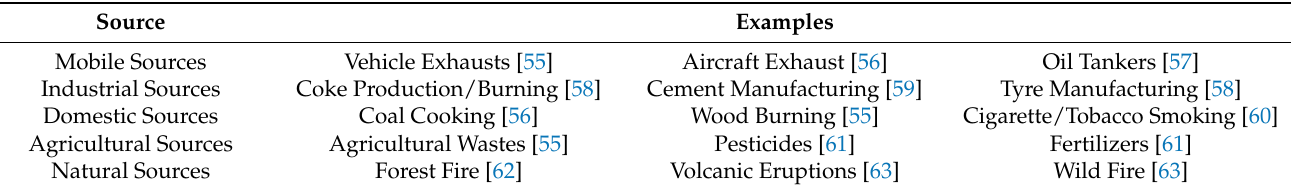
Table 2. Different sources of